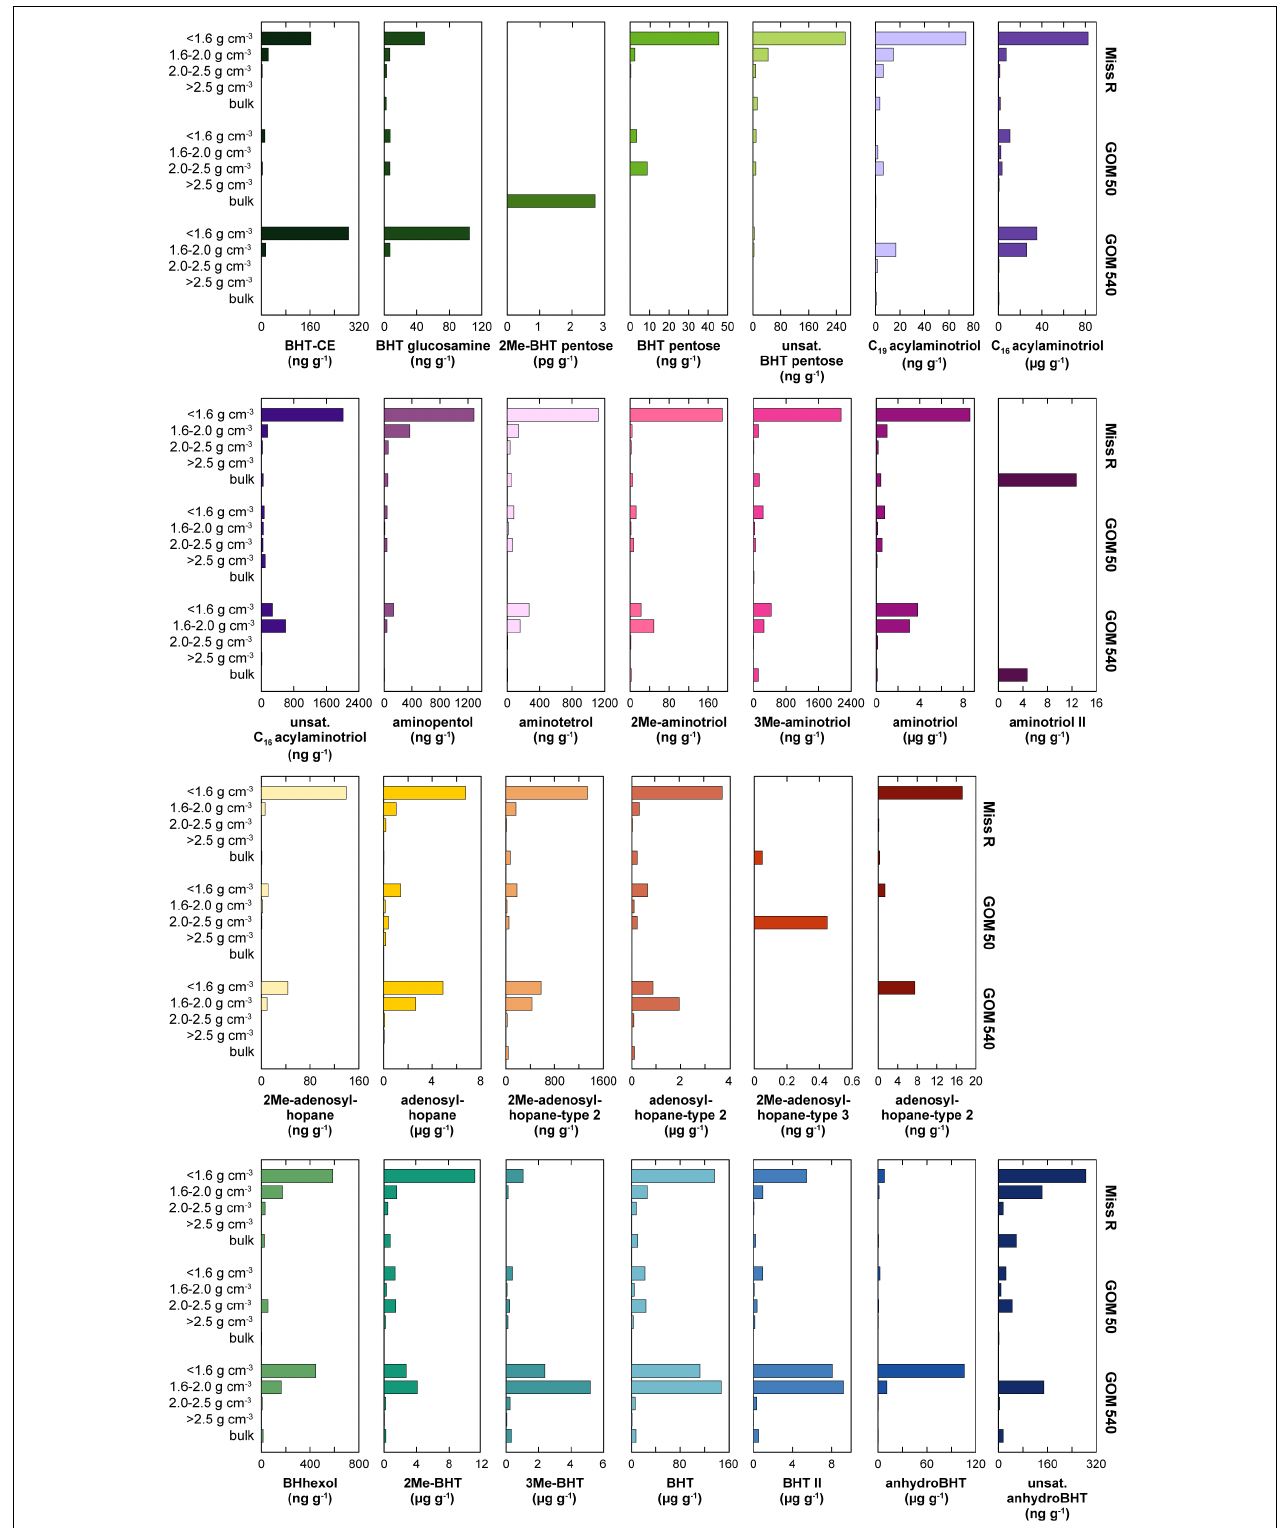
FIGURE 5 | Absolute abundance of individual BHPs in density fractions and bulk sediment samples along the Miss R – GOM transect. Individual BHP abundances are mass-normalized to better reflect the physical partitioning of particles during cross shelf transport. Low abundances are not well resolved graphically, we refer to Supplementary Table S1 for details. Also note different